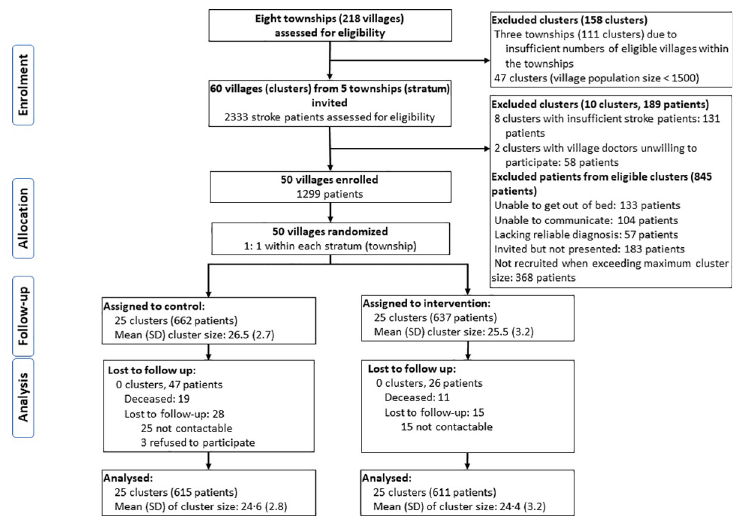
Fig 1. Flow diagram of trial